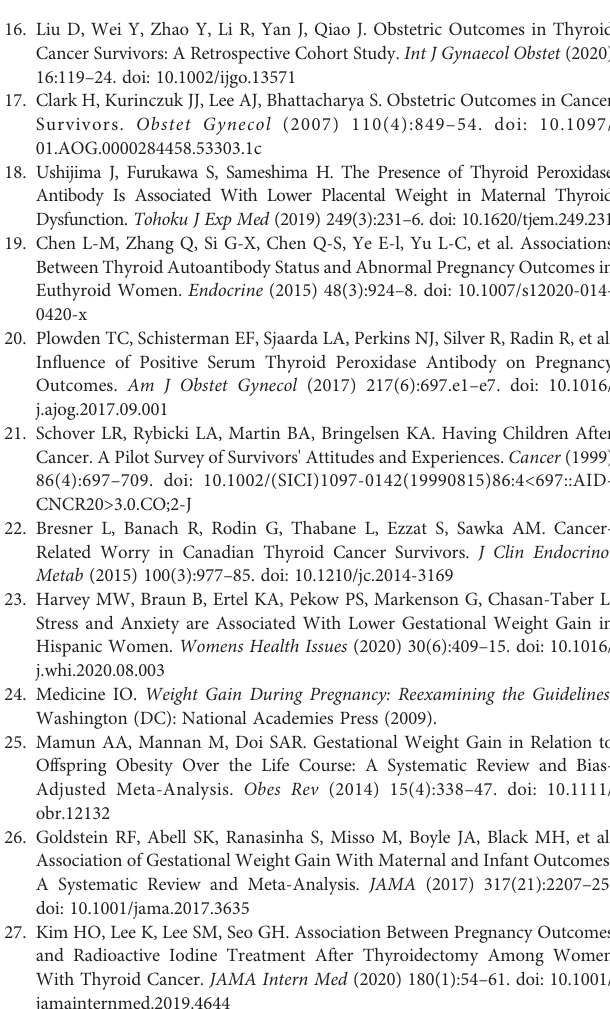
Supplementary Figure S1 | (A – C) . Directed acyclic graph illustrating confounder selection. IVF, in vitro fertilization; BMI, body mass index; fT4, free thyroxine; TSH,